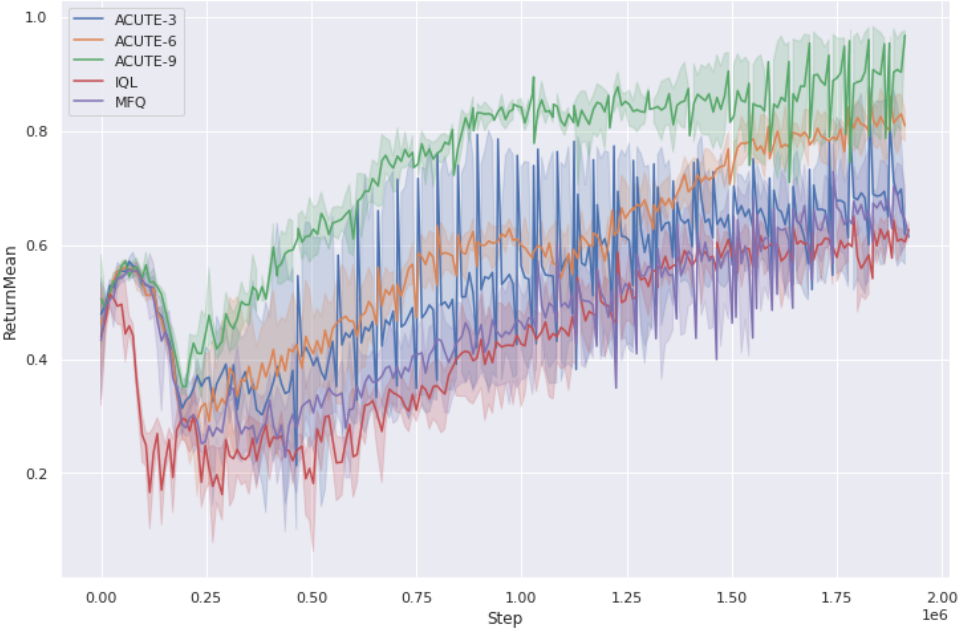
Figure 6. Experiment result in lbforaging: 5s-19 × 19-19p-9f.